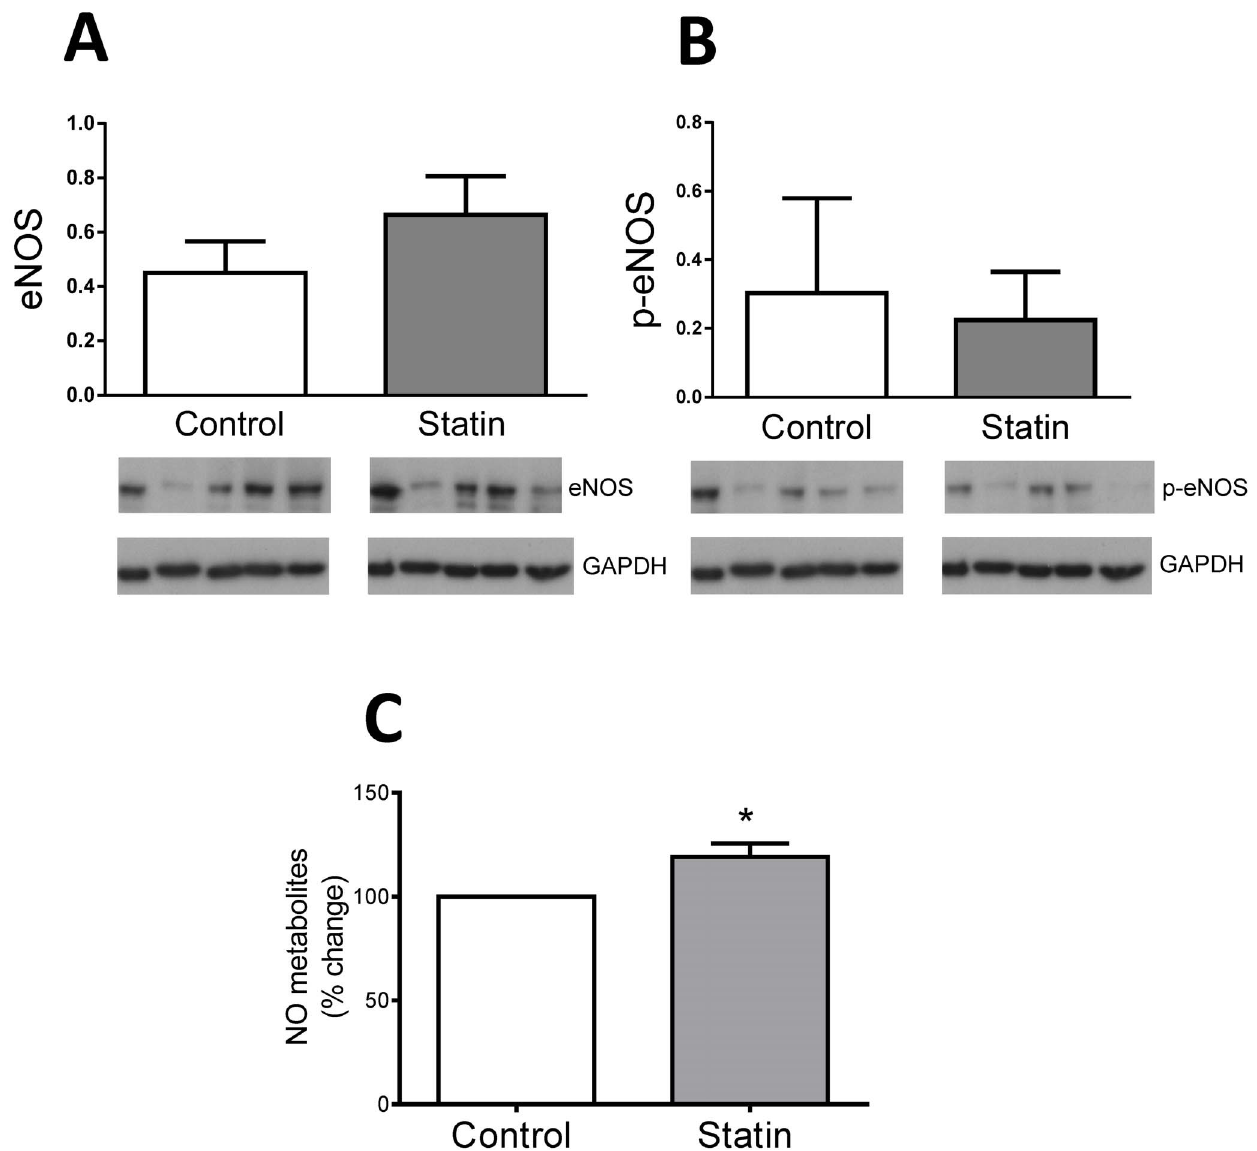
Figure 8. The effect of simvastatin on eNOS and NO production. A. Total eNOS expression normalised to GAPDH in control and simvastatin- treated cells. B. Ser 1177 -phosphorylated eNOS normalised to GAPDH in control and simvastatin-treated cells. Data are from cells from n=5 hearts. C. Medium was collected from myocytes cultured for 48 h in the presence or absence of simvastatin. NO metabolites (nitrate/nitrite) were measured by a fluorimetric assay. Data are [nitrite + nitrate] normalised to values in paired control group (cells from n=6 hearts). * P , 0.05, Student’s